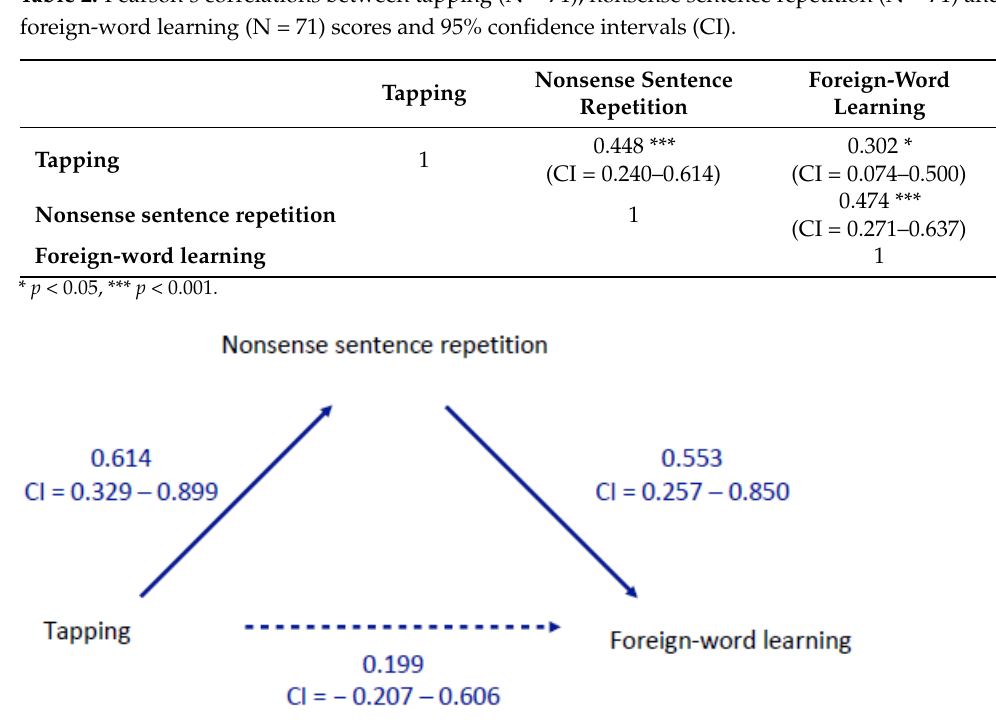
Figure 1. Mediation model showing the direct path from tapping to foreign-word learning and the indirect path from tapping to foreign-word learning as mediated by nonsense sentence repeti- tion. CI = 95% confidence interval. Paths for which the confidence interval includes zero are not considered